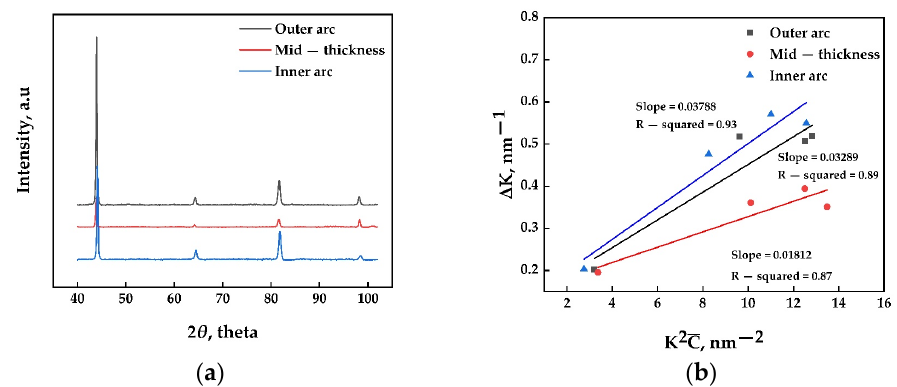
Figure 6. The XRD patterns of the 5% Ni steel samples. ( a ) X-ray diffraction profiles of samples at the bending axis. ( b ) Linear relationship between Δ K and K 2 𝐶 based on the modified Williamson–Hall method.